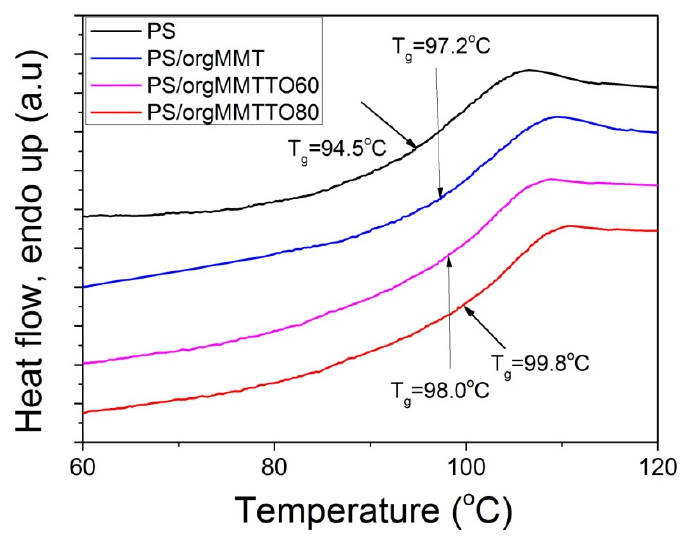
Figure 8. Indicative differential scanning calorimetry (DSC) data showing the estimation of the glass transition temperature, Tg of PS and some of its nanocomposites.